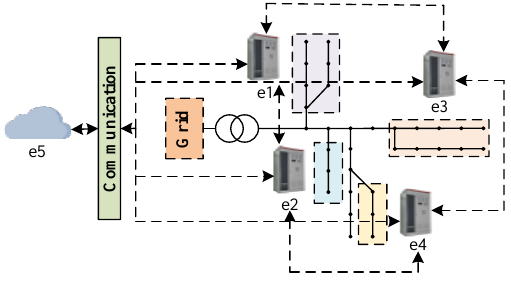
Figure 3. An Improved IEEE 33 System.